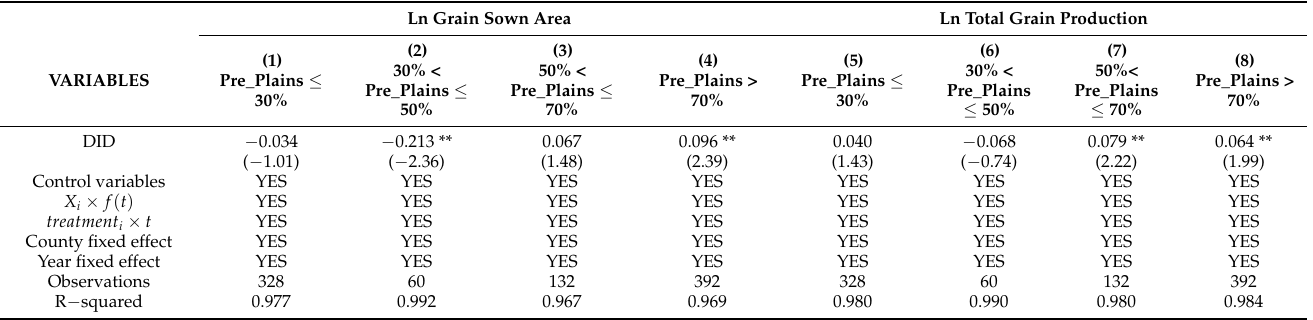
Table 9. Differences in terrain and